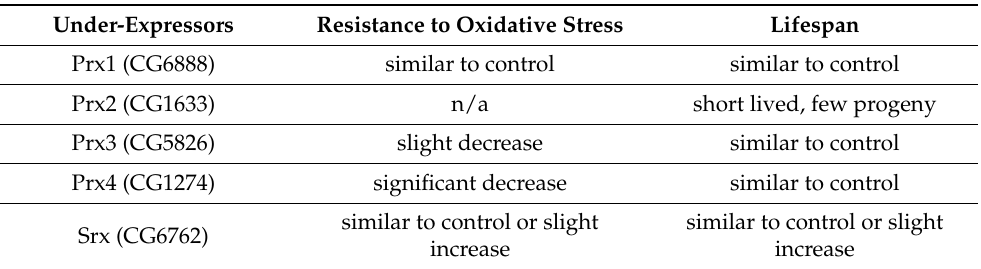
Table 1. Effects of underexpression of Prxs and Srx on lifespan and resistance to oxidative